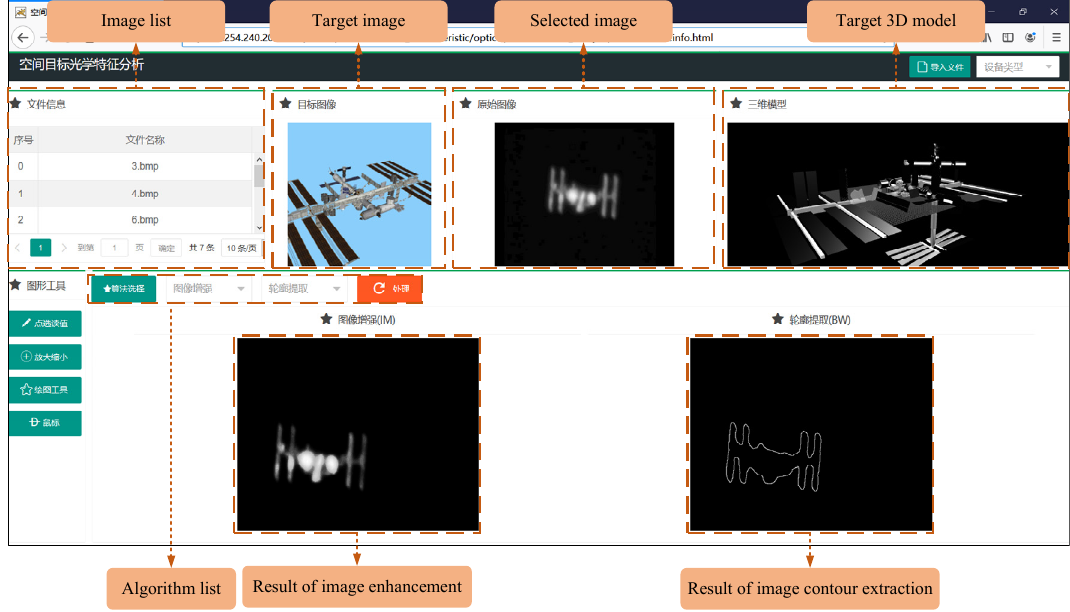
Figure 20. Web page of the algorithm level case. Based on the MATLAB algorithms of image enhancement and contour extraction, various online services can be proposed.